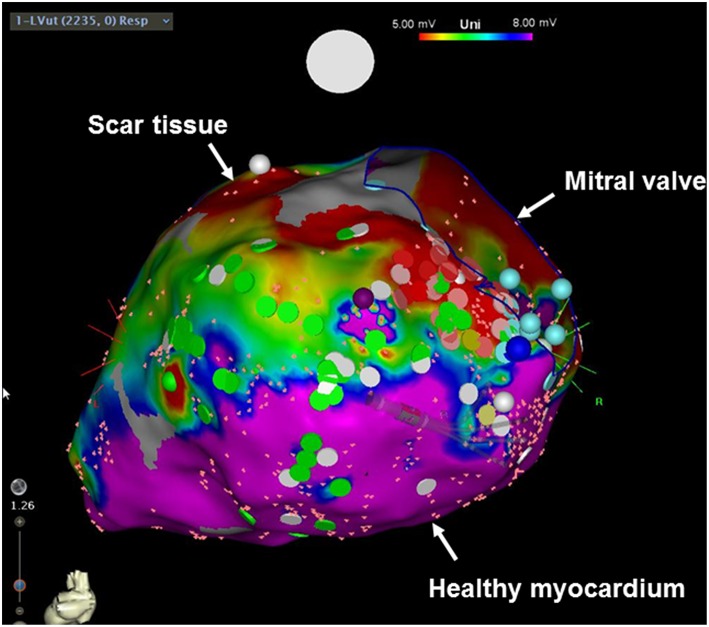
Electroanatomical voltage mapping of the left ventricle (posterior view). Red areas indicate scar tissue, whereas pink areas demonstrate healthy myocardium.